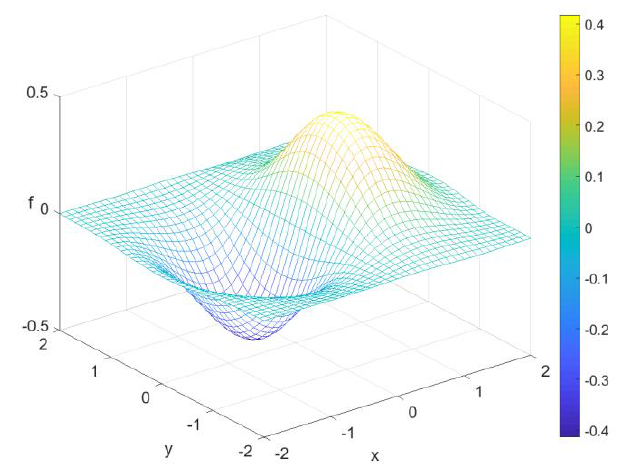
Figure 3. Orientation of B-splines’ boundaries over the domain